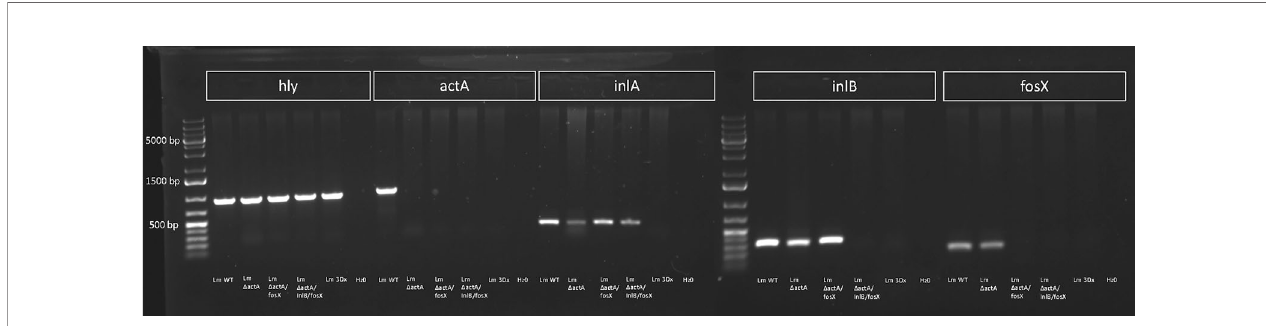
FIGURE 2 | PCR for hly, actA, inlA, inlB and fosX of WT, Lm3Dx and intermediate mutants at passage 100. All strains harbor the hly gene encoding for Listeriolysin O that was used as species control for Listeria monocytogenes . Deletions of actA, inlA, inlB and fosX are stable across 100